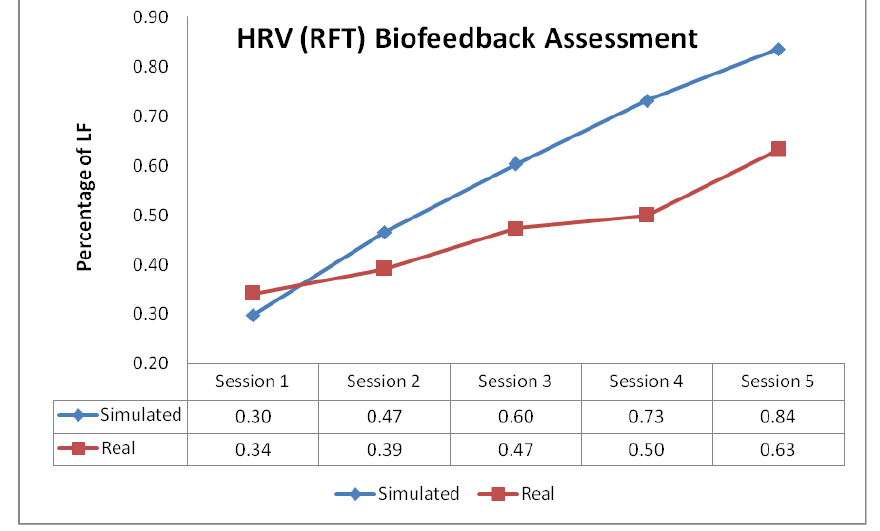
Figure 2. “Change in percentage of Low Frequency (LF) activity throughout five Sessions in simulated and real operators”. Source: Own